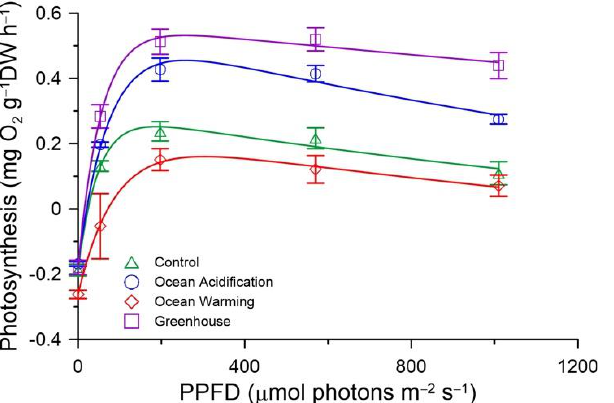
Figure 1. Net photosynthesis of Caulerpa sertularioides after exposure to present and three simulated future ocean conditions for 15 days. Data are represented as mean ± SE (n = 3). Table 2. Photosynthetic parameters of Caulerpa sertularioides from oxygen measurement (P-E curves) and chlorophyll-a fluorescence measurement (RLCs: rapid light curves) after 15 days under present and three future ocean conditions.